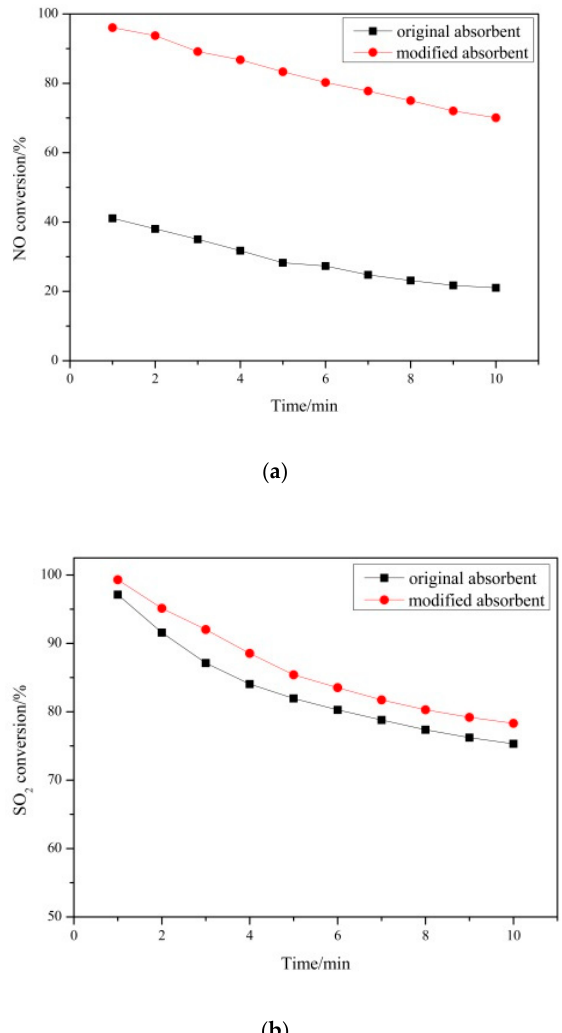
Figure 4. Desulfurization and denitrification performance before and after modification of absorbents: ( a ) NO conversion as a function of the time of the original absorbent and modified absorbent and ( b ) SO 2 conversion as a function of the time of the original absorbent and modified absorbent.